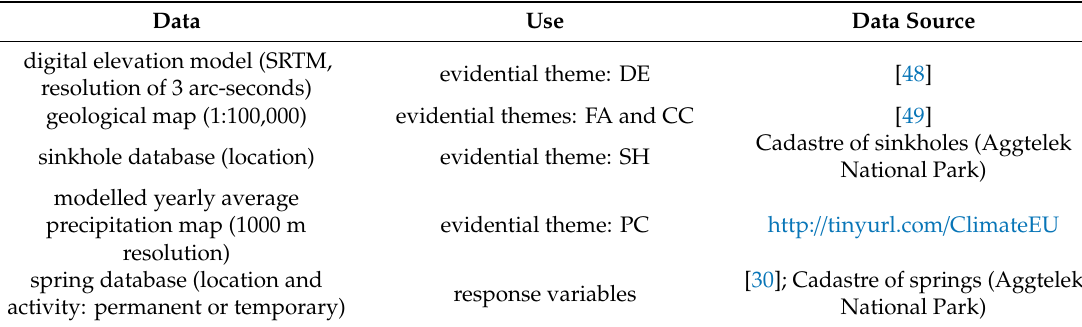
Table 2. Data sources and their uses.